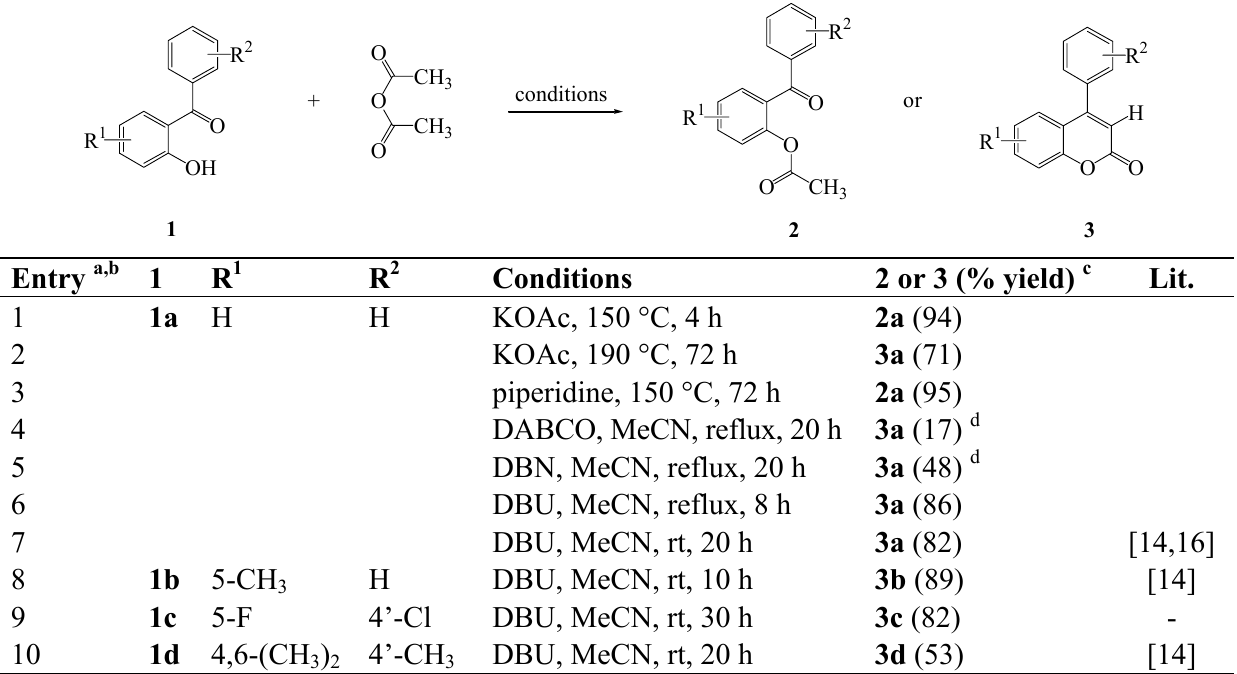
Table 1. Kostanecki acylation of 2-hydroxybenzophenones with acetic anhydride.